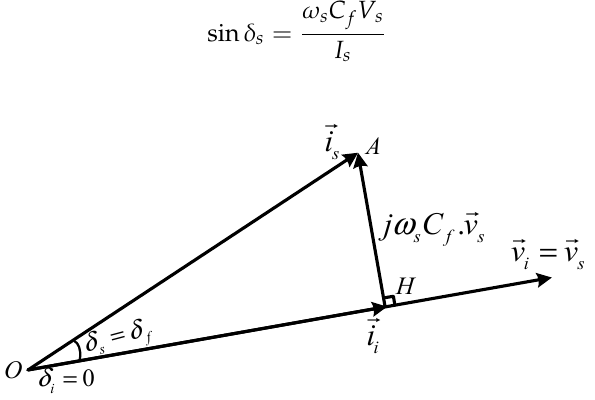
Figure 6. Vector diagram of input voltages and currents with no compensated angle ( δ i = 0